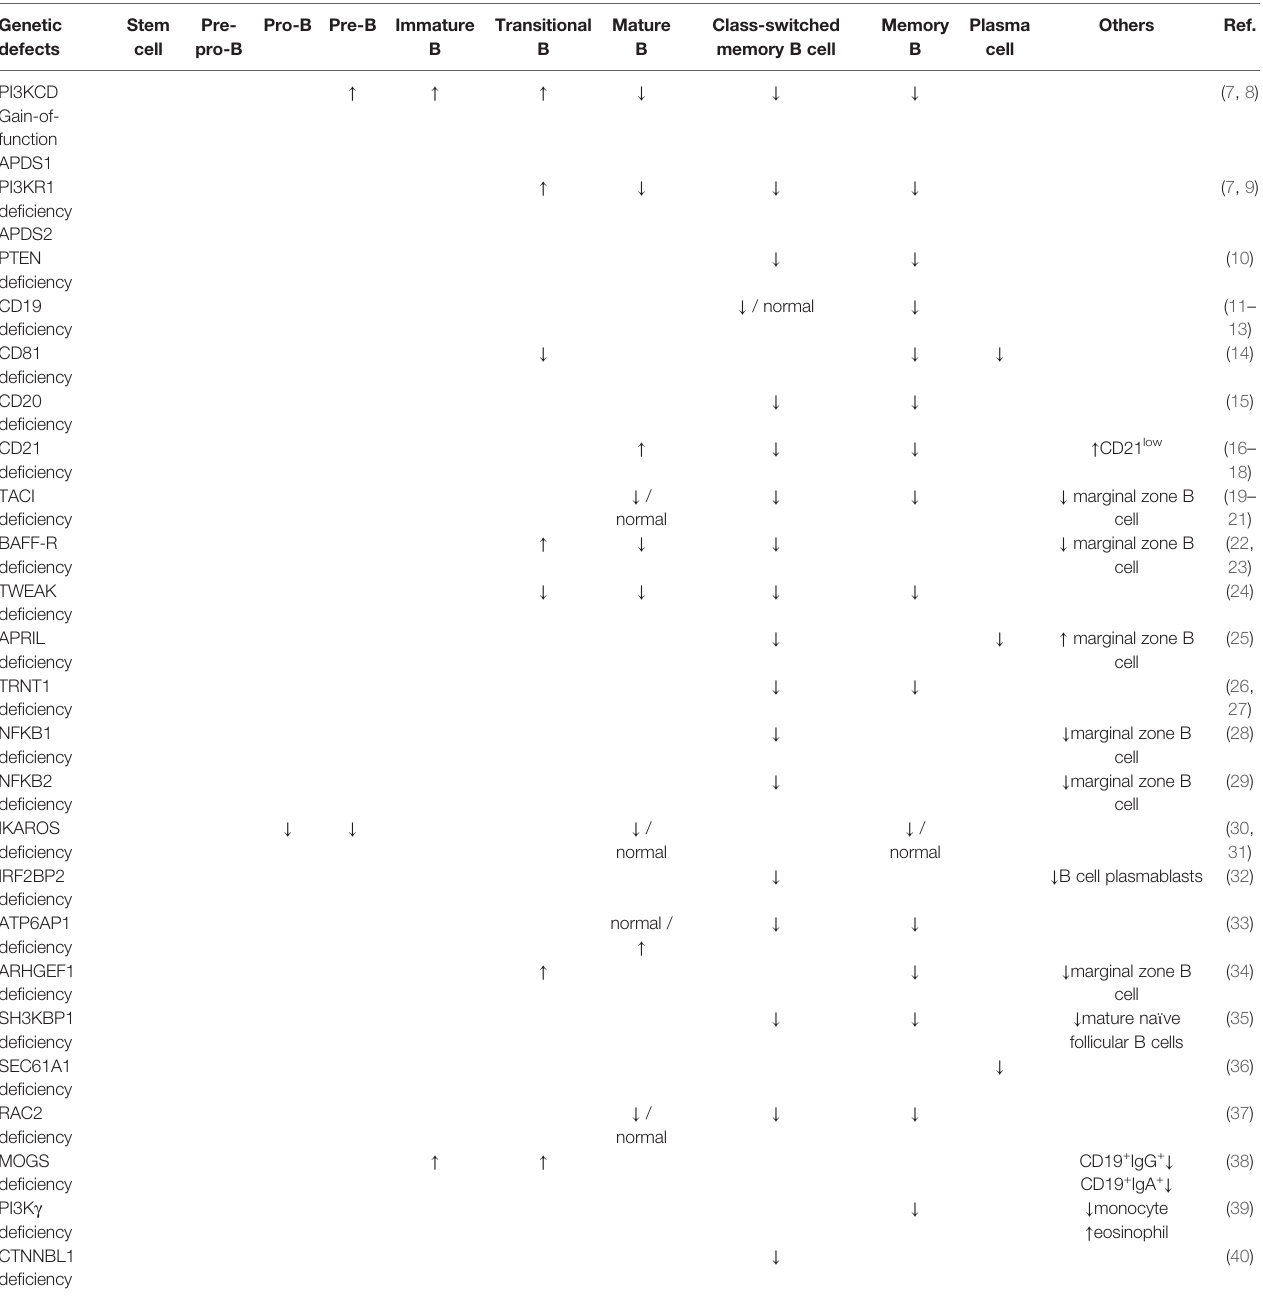
TABLE 1 | B-cell subset abnormalities in monogenic